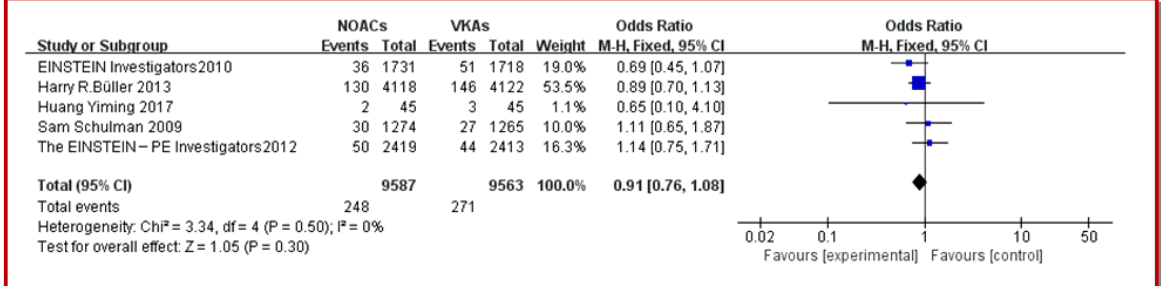
Figure 2: Forest plot of risk of recurrent venous thromboembolism (VTE) between NOACs and vitamin K antagonists